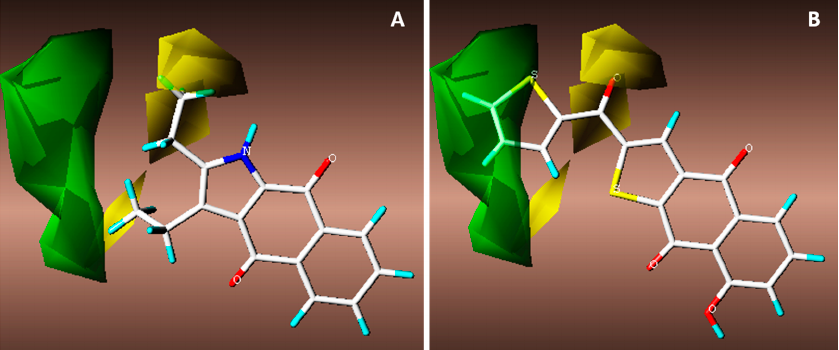
Figure 3. Steric contour maps generated by comparative molecular field analysis (CoMFA) for: ( A ) 2,3-diethyl-1 H -benzo[ f ]indole-4,9-dione ( 2d ), the least active compound of the series; and ( B ) hydroxy-2-(thiophen-2-ylcarbonyl)naphtho[2,3- b ]thiophene-4,9-dione ( 7 ), the most